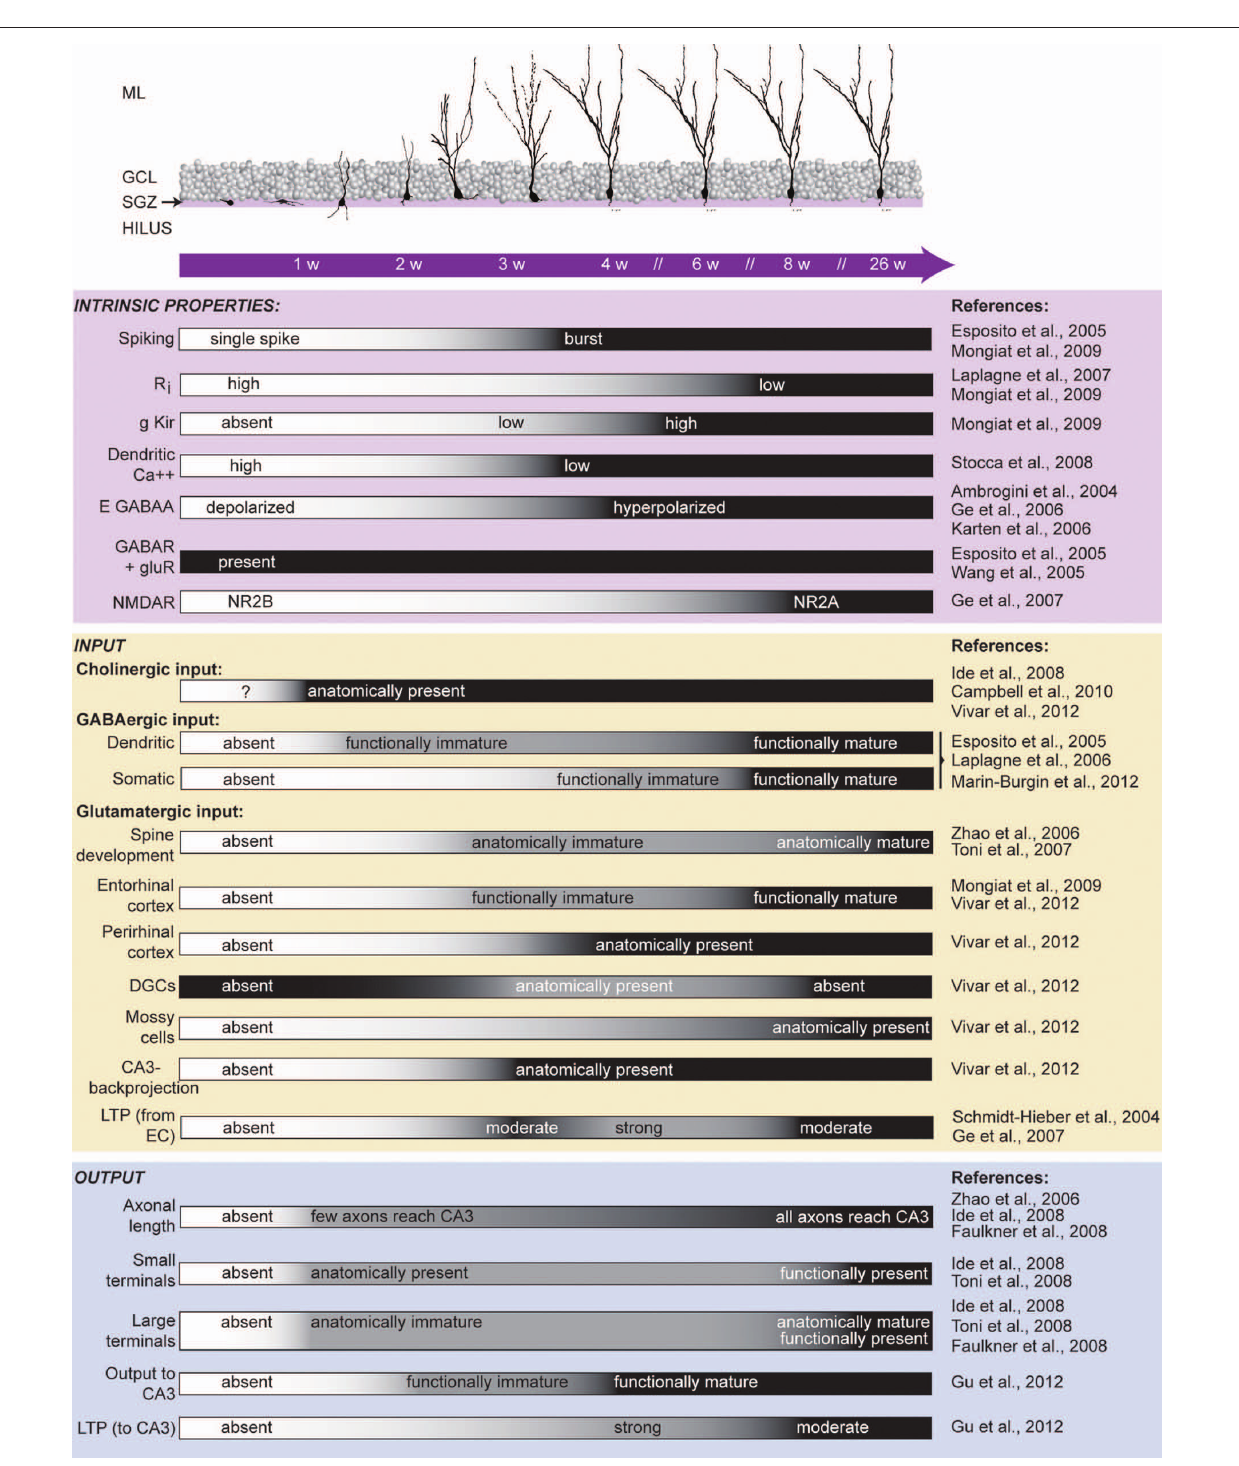
FIGURE 2 | Maturation of adult-born DGCs. Critical time points over a period of several weeks are indicated within the purple bar. (Top) The morphological maturation of dendritic arbors of adult-born DGCs (adapted from Esposito et al., 2005). Axonal arbor development is not shown. (Bottom) Summary of reported findings during the maturation of adult-born DGCs. Each characteristic is listed to the left with references from which the timeline is depicted cited to the right. Black